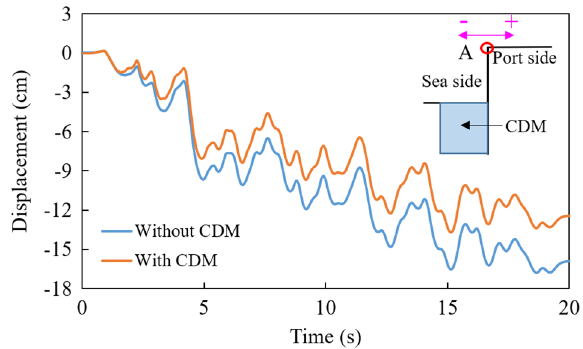
Fig. 7 Horizontal displacement at point A (the Coalinga